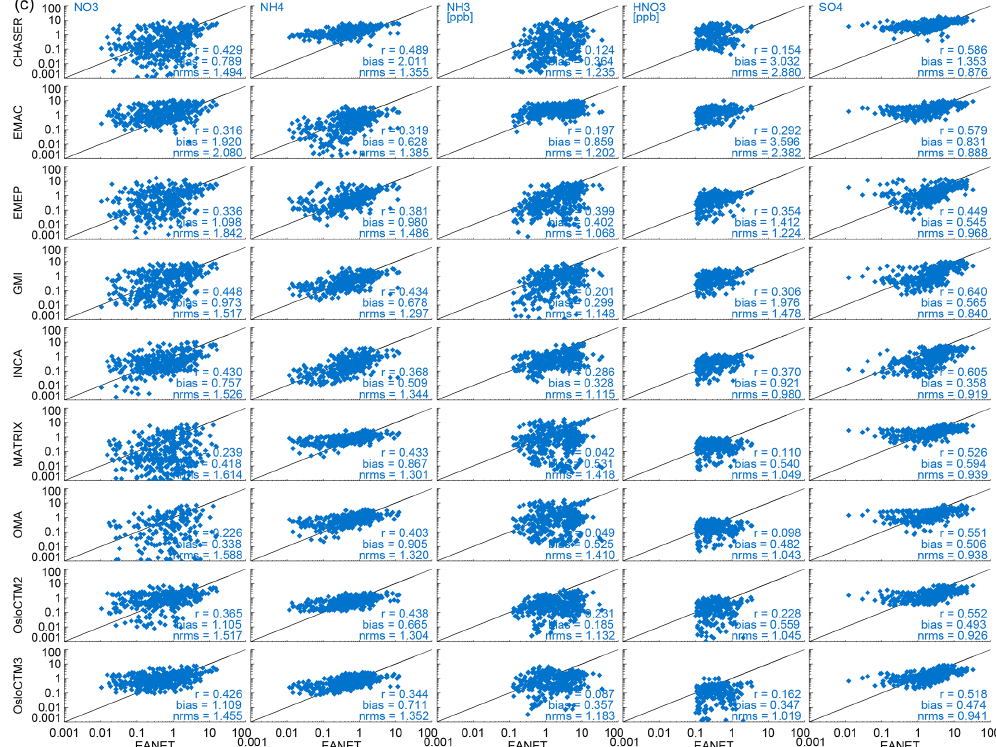
Figure 4. (a) Comparison of surface mixing ratios of NO − Units are µgm − 3 . Panel (b) is the same as (a) but for EMEP. Panel (c) is the same as (a) but for EANET.